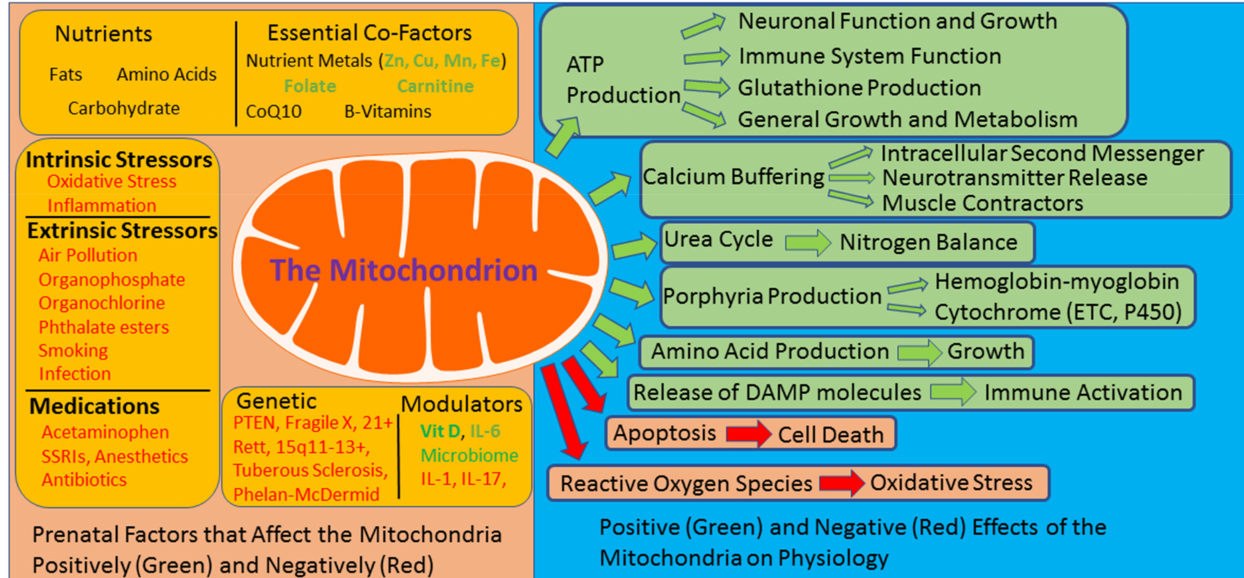
Figure 1. The mitochondria can be negatively affected by many environmental and biological factors associated with autism spectrum disorder (left orange panel) and has many critical roles in cellular physiology (right blue panel). ETC: electron transport chain; DAMP: damage-associated molecular